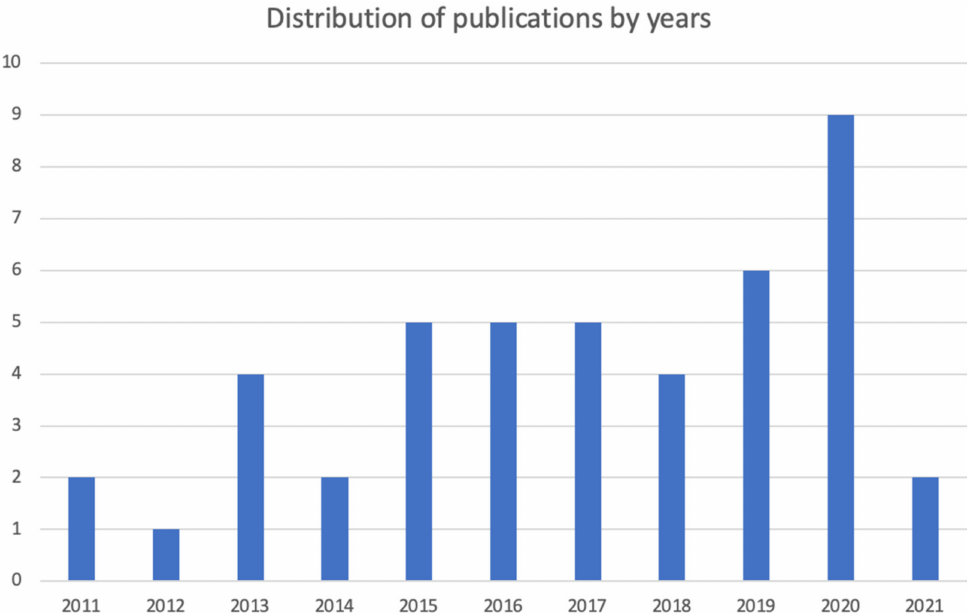
Figure 5. Distribution of publications by years.